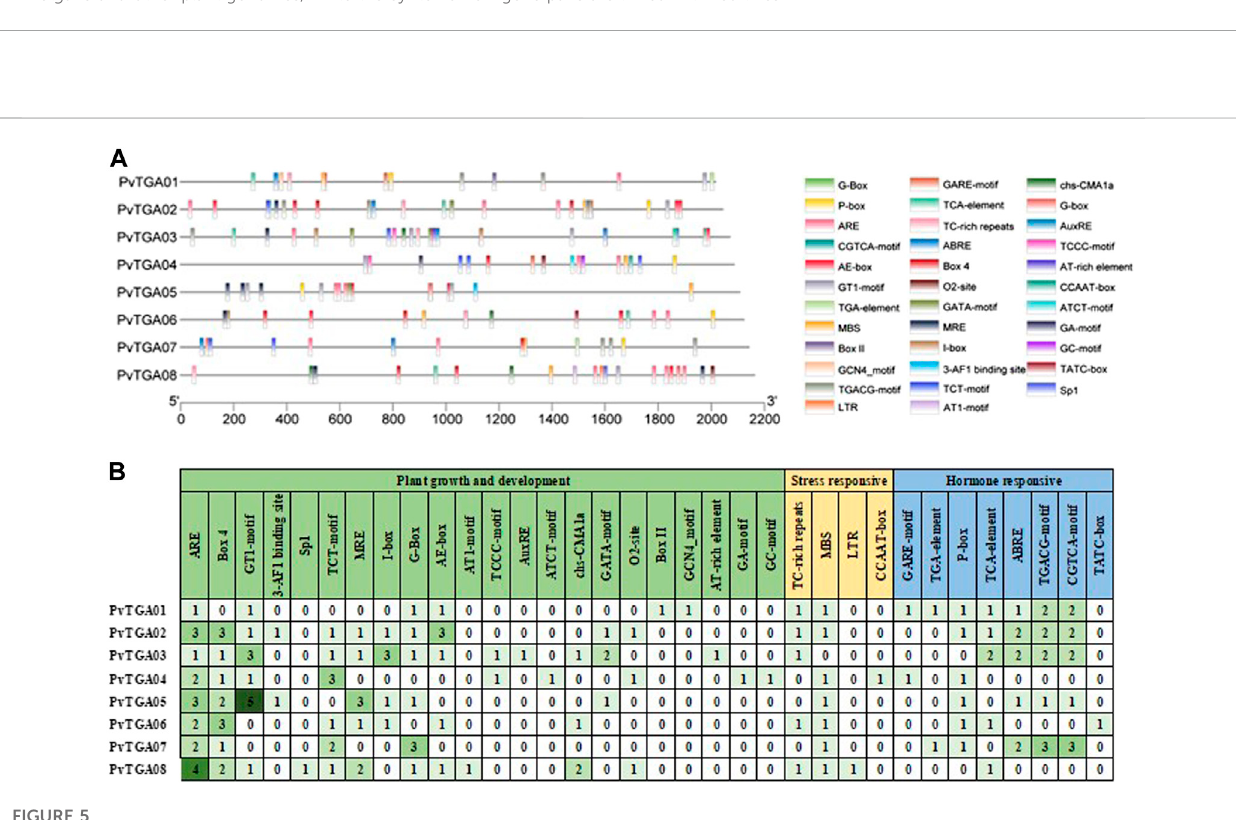
FIGURE 4 Genome scale synteny analysis of Phaseolus vulgaris , Arabidopsis , Glycine max , Vitis vinifera , Medicago truncatula , Cicer arietinum , rice, corn and sorghum TGA genes. (A) syntenic relationship of P. vulgaris TGA genes. All 8 TGA genes are marked according to their chromosome distribution in common bean genome and syntenic gene pairs are connected with blue lines., (B) syntenic pairs of TGA genes between P. vulgaris and other plants. The Phaseolus vulgaris ( P. vulgaris ), Arabidopsis thaliana ( A.thaliana ), Arachis hypogaea ( A.hypogaea ), Glycine max ( G. max ), Cicer arietinum ( C. arietinum ), Vitis vinifera ( V. vinifera ), Medicago truncatula ( M. truncatula ), Oryzae Sativa ( O. Sativa ), Zea mays ( Z. mays ) and Sorghum bicolor ( S. bicolor ) chromosomes are shown in blue, lightgreen, green, yellow, orange, grey, purple, pink, brown and red bars, respectively. Gray lines in the background indicated the collinear blocks within P. vulgaris and other plant genomes, while the Syntenic TGA gene pairs are linked with red lines.